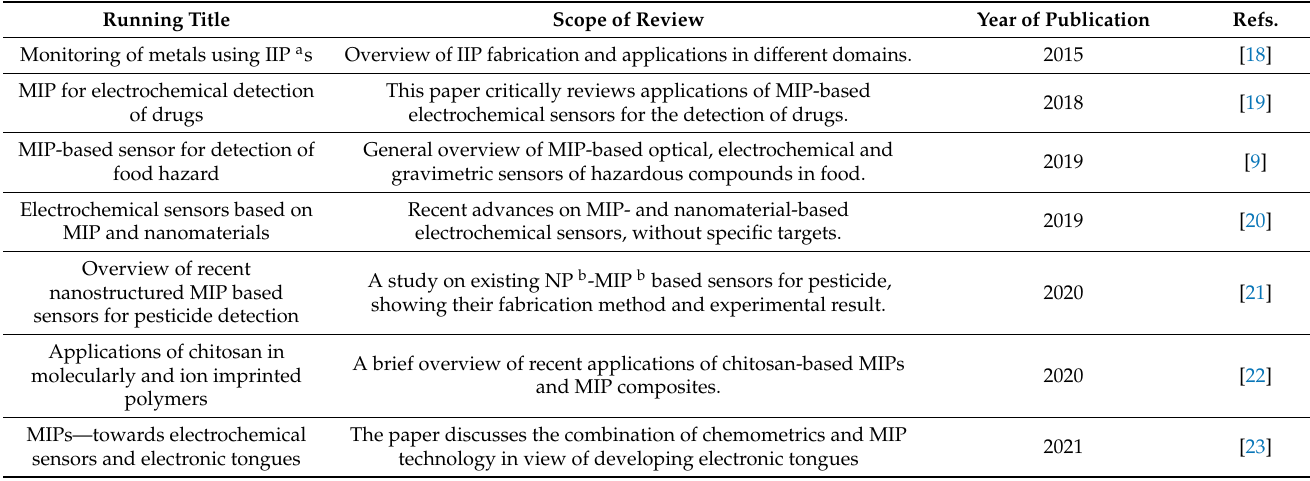
Table 1. Handpicked reviews on MIPs for the detection of chemicals and pathogenic